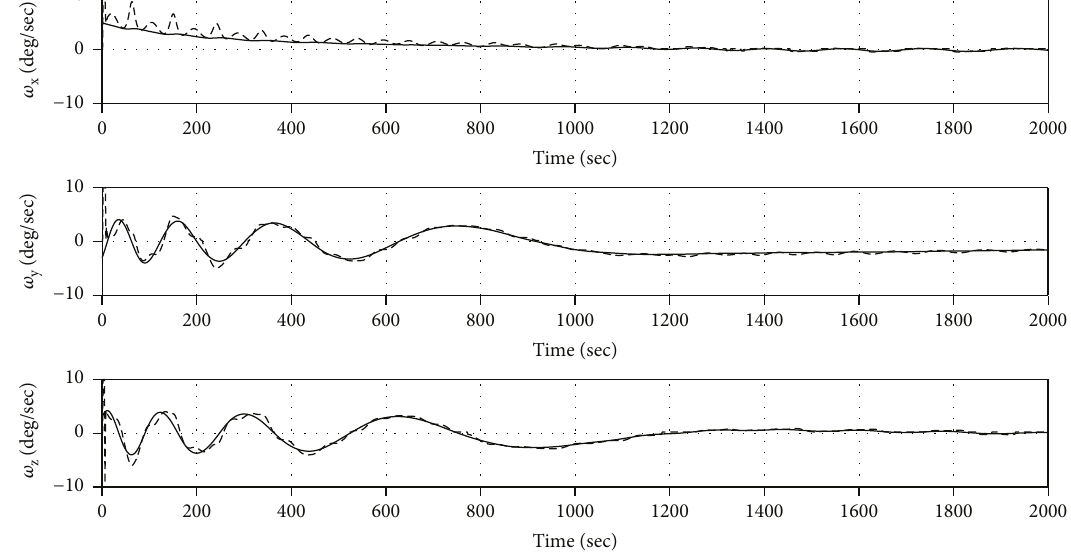
Figure 5: Actual and measured angular rates ( ω